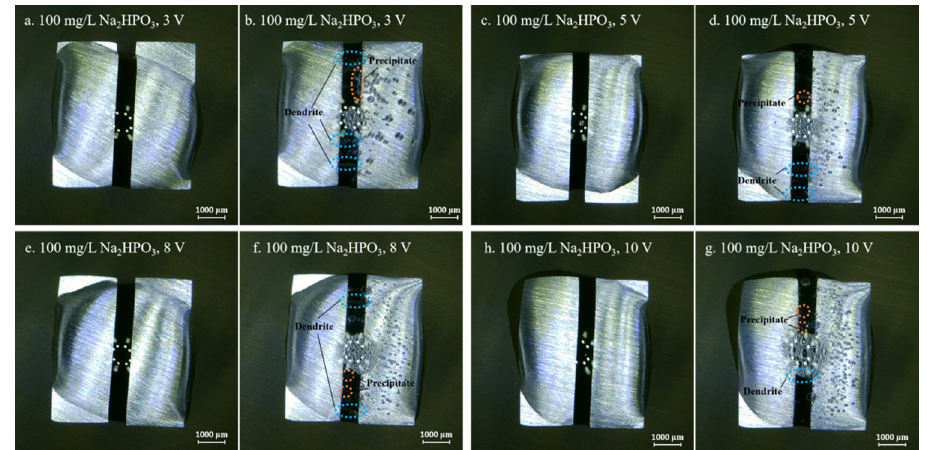
Figure 5. Optic photos for ECM tests of tin under a droplet of 15 μ L containing 50 mg/L Na 2 HPO 4 at various bias voltages (Anode is on the left and cathode is on the right).